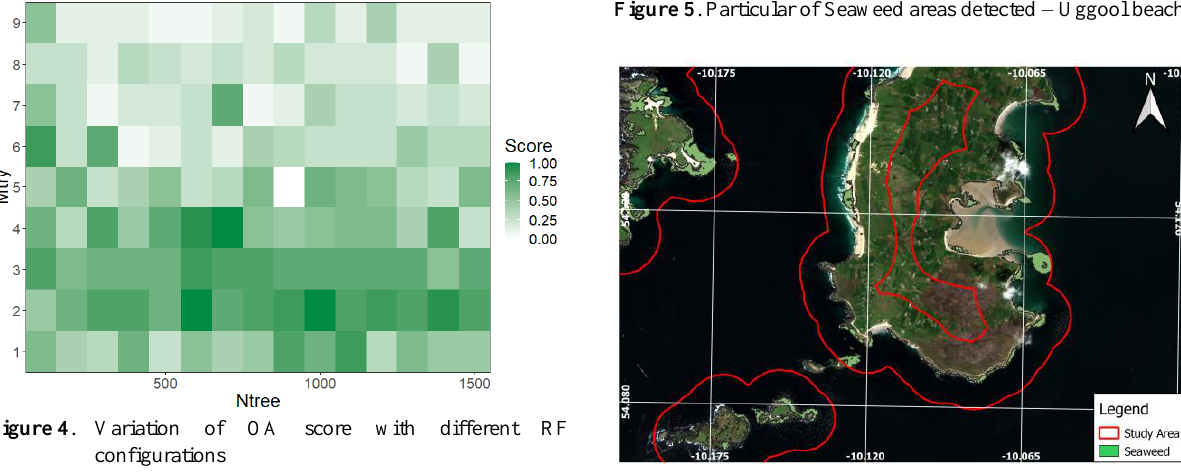
Figure 6 . Particular of Seaweed areas detected – Blacksod